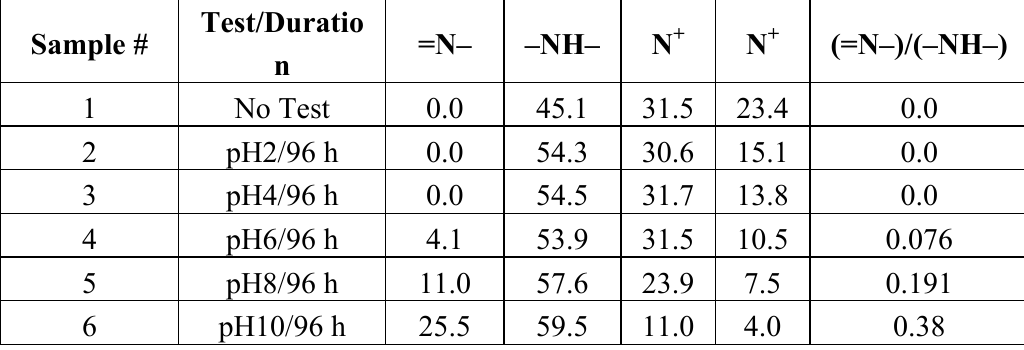
Table 1. Data from XPS N 1s spectra obtained from 120 µm PANI composite thick